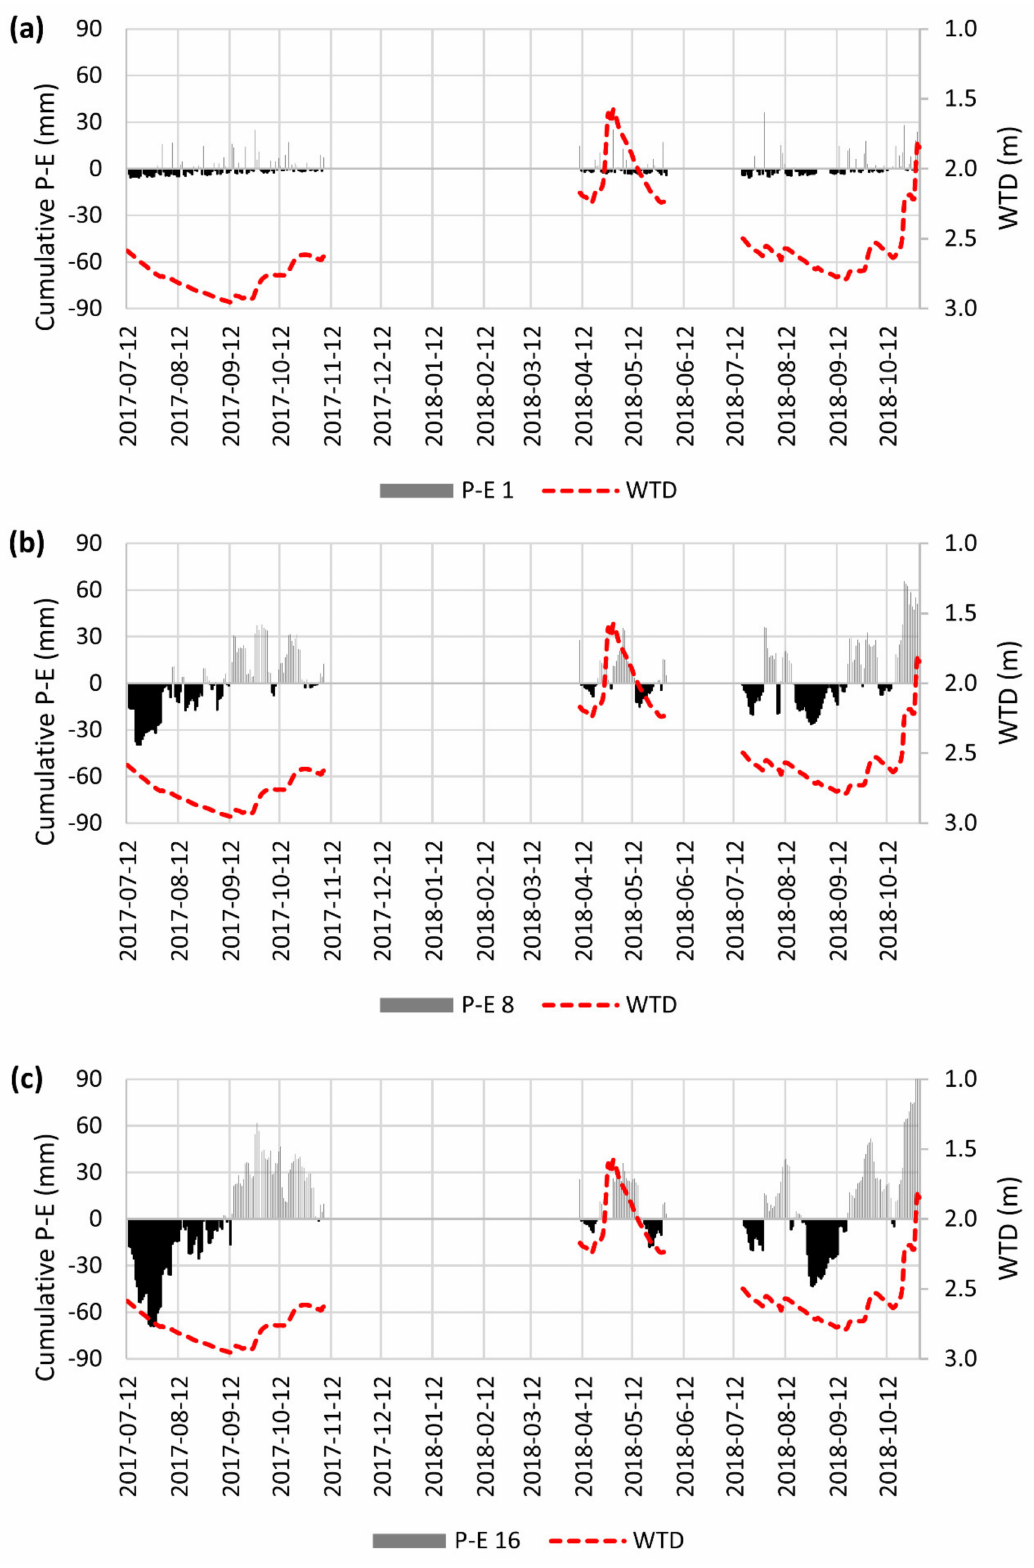
Figure A2. Time lag for water table response to cumulative P-E (daily precipitation minus daily evapotranspiration; ( a ) one-day time lag, ( b ) 8-day time lag, and ( c ) 16-day time